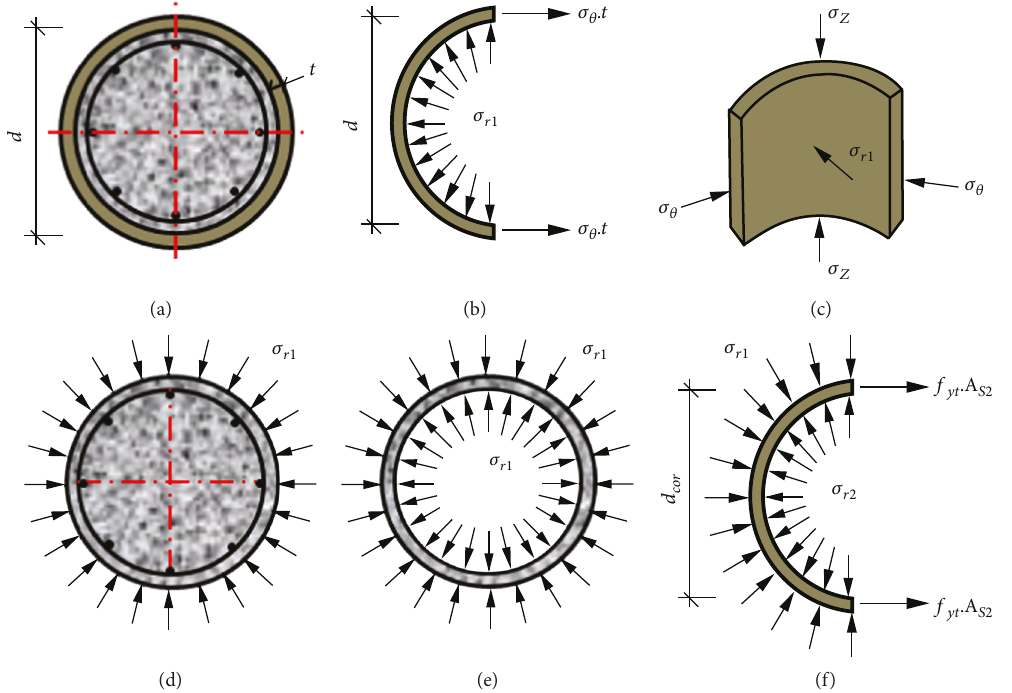
Figure 5: Semicircle steel shield and the force of